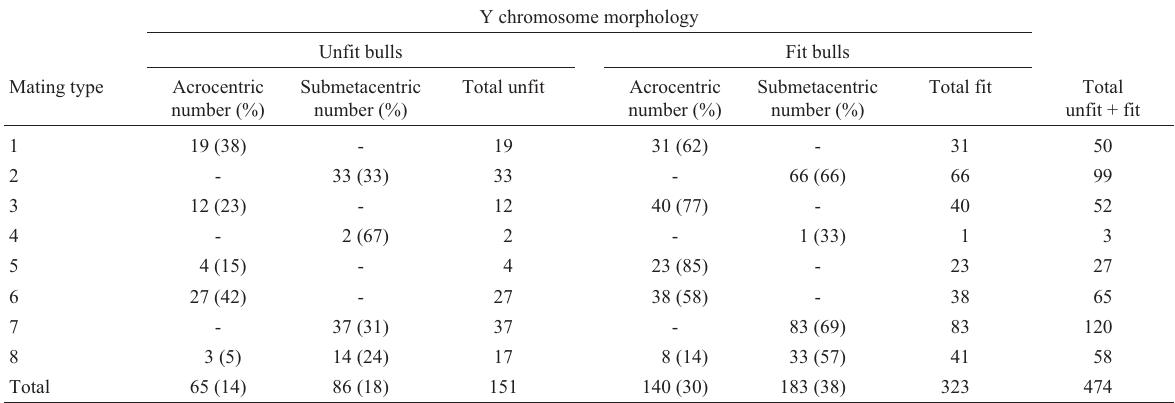
Table3 -GenealogicallydeterminedfrequencyofthedifferentYchromosomemorphologicaltypesfoundinreproductivelyfitandunfitBrafordbulls. Y chromosome morphology